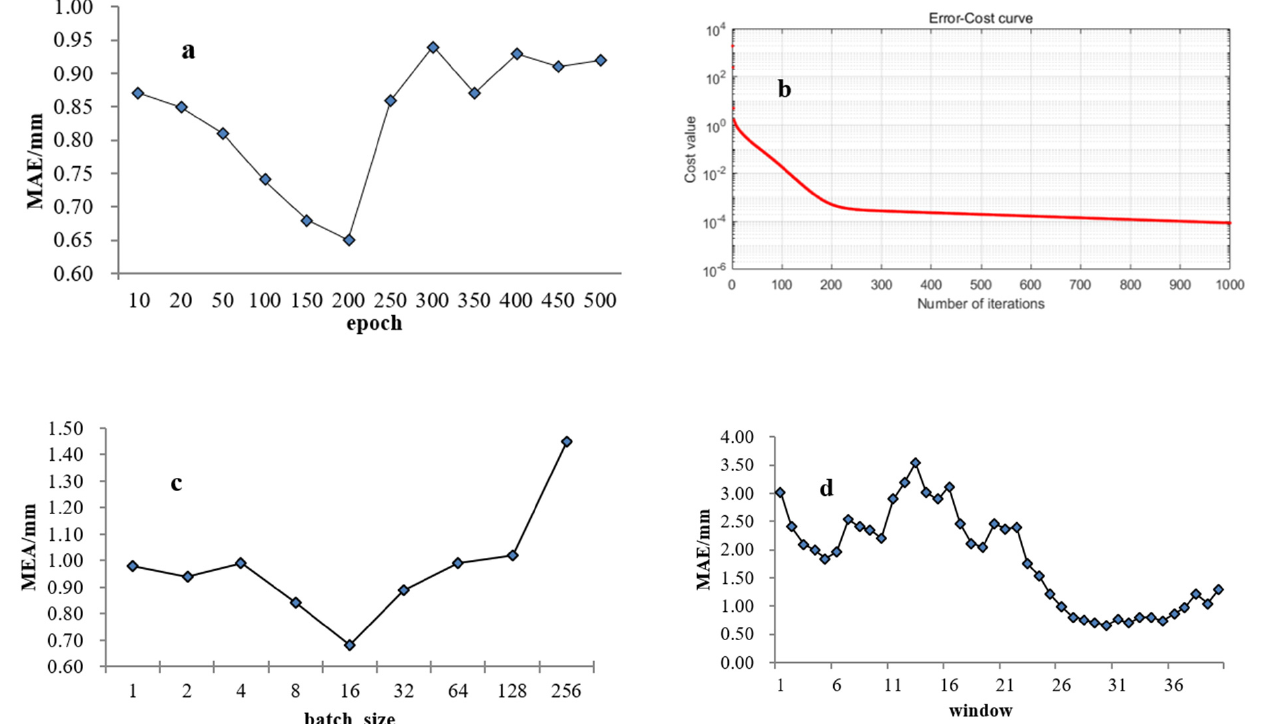
Figure 17. Influence of super parameters on LSTM model errors. ( a ) different epochs with MAE. ( b ) error cost with number of iterations. ( c ) different batch_size with MAE and ( d ) different window with MAR.